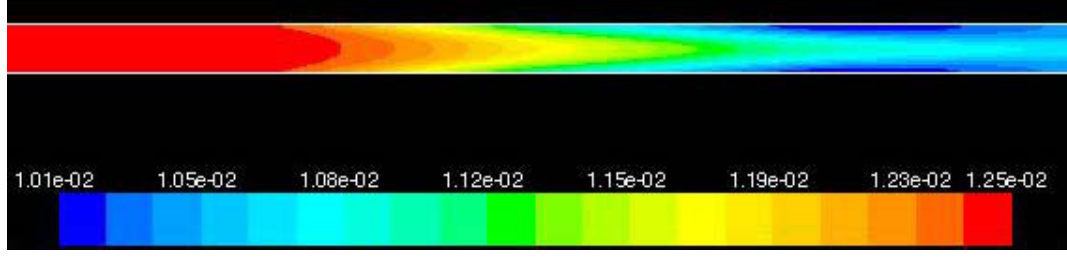
Figure 2. Mole fraction contours of C